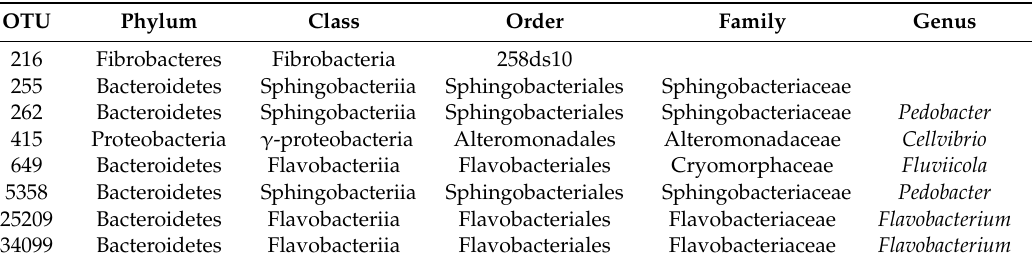
Table 4. Unique* 16S taxa of poultry litter compost identified as those common in both Lilac and Wheelock fields separately. *: See Tables S3 and S4 for a complete list of the most abundant classified 16S and ITS taxa identified in all treatments and both fields, respectively.